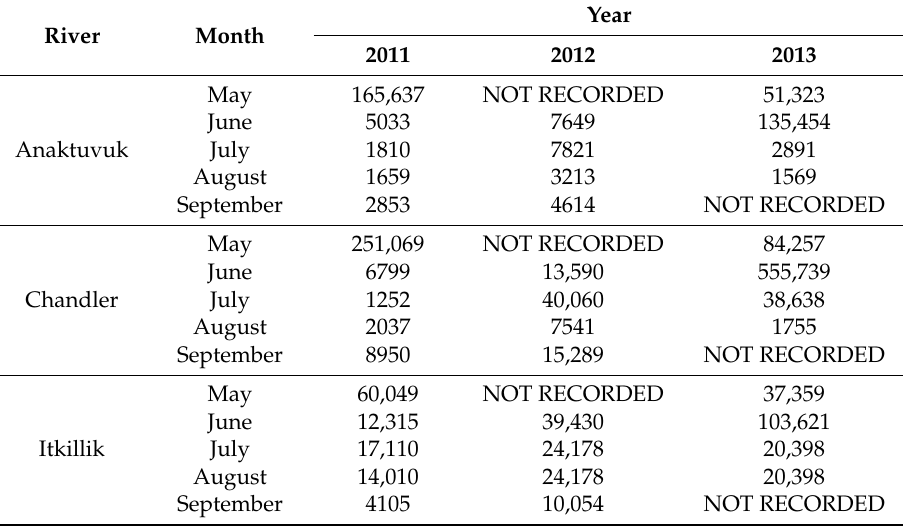
Table 2. Suspended sediment yields for each river for 2011–2013, in metric tonnes per month.